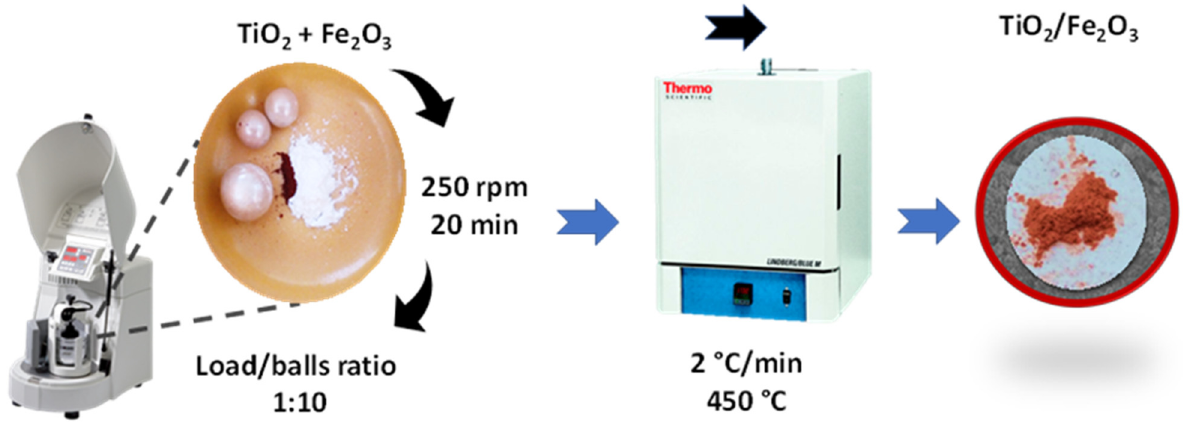
Figure 1. Diagram showing the synthesis of TiO 2 /Fe 2 O 3 composite by the mechanosynthesis method.